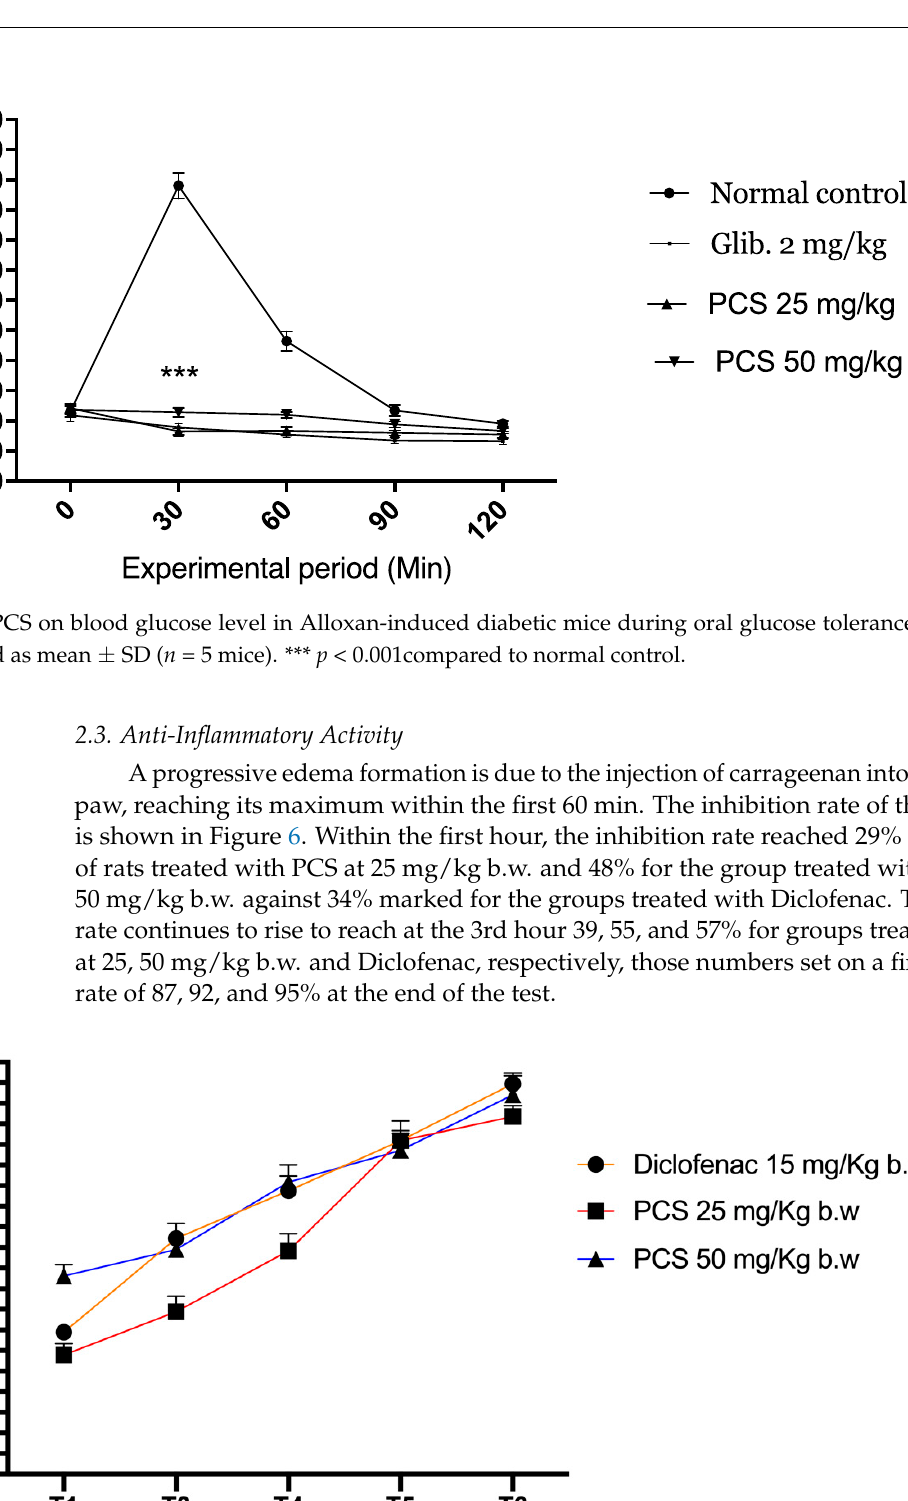
Table 4. Summary of in vitro antioxidant activity results.